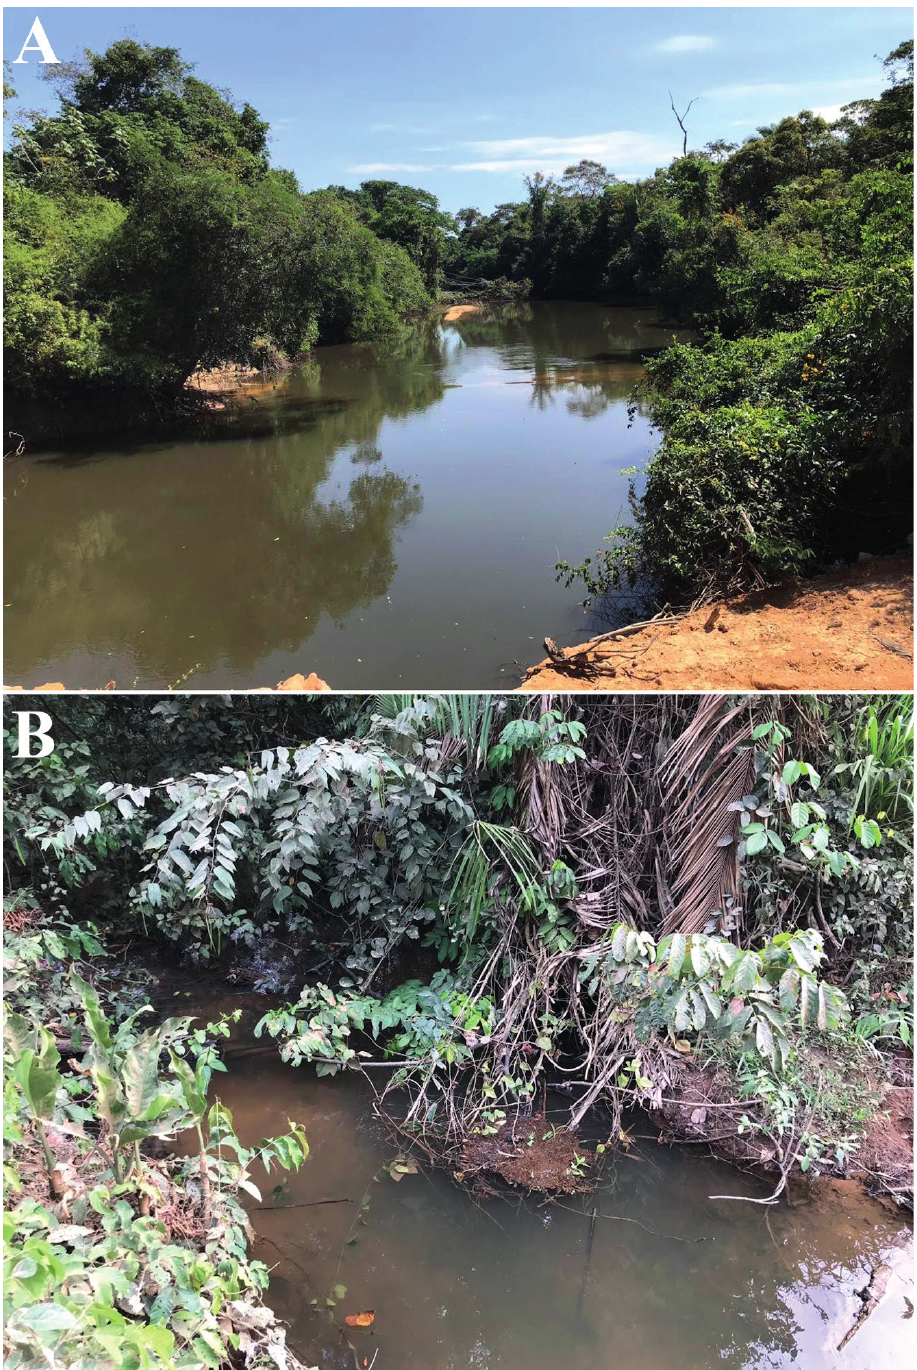
FIGURE 6 | Natural habitat of Corydoras thanatos and C. hypnos , showing ( A ) the rio Jamanxim, type locality of